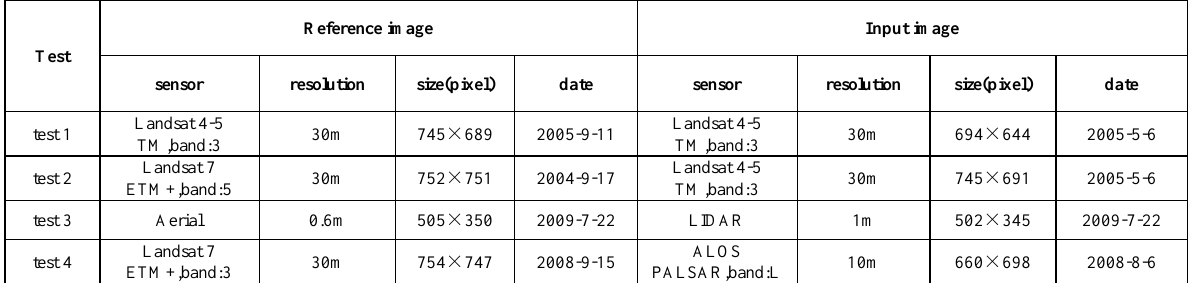
Table 1. The parameters of the test